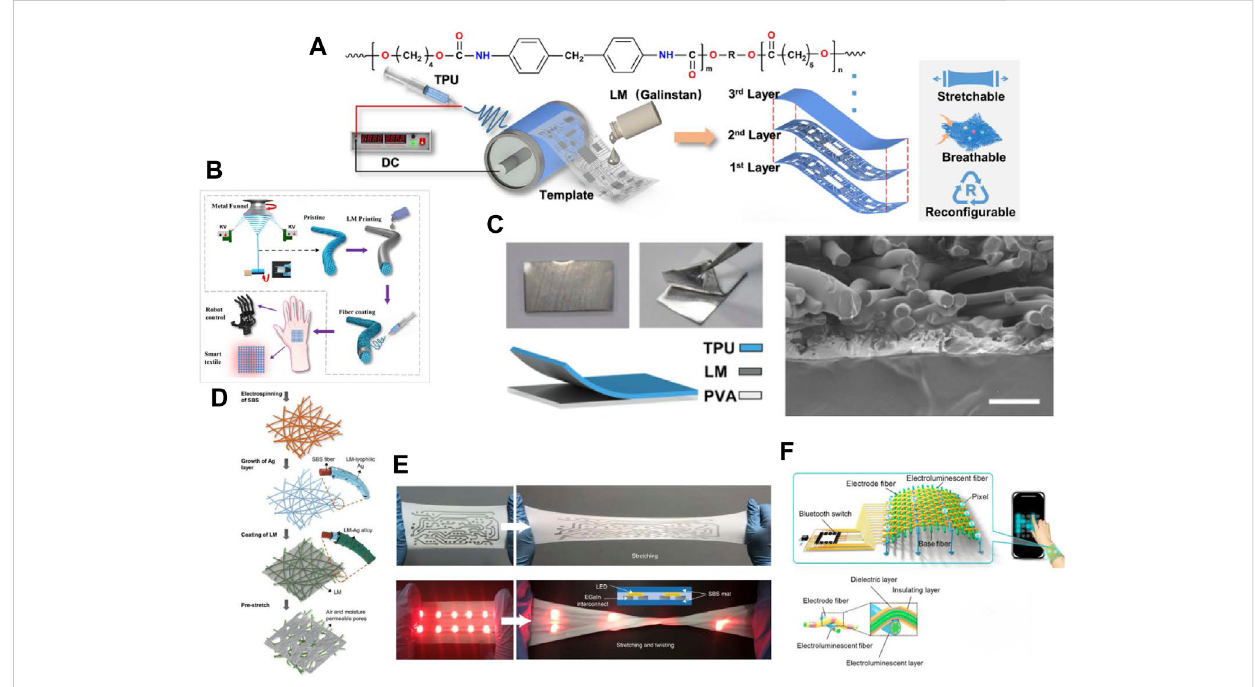
FIGURE 6 Liquid metalenabledelastic electronicsbasedon fi bers. (A) Sensormadeofliquidmetal printedonelectrospinning substrate(WANGetal.,2021) (B) Making soft sensor by coating liquid metal on electrospun fi ber (UZABAKIRIHO et al., 2022) (C) Stretchable adhesive liquid metal fi ber mat (WANG et al., 2022d) (D) Compositeelectrodemade ofliquid metal fi ber mat (ZHUANG etal., 2021) (E) Liquid metal fi ber matwith LED(MA etal., 2021) (F) Liquid metal fi ber that can emit light and image (MI et al.,